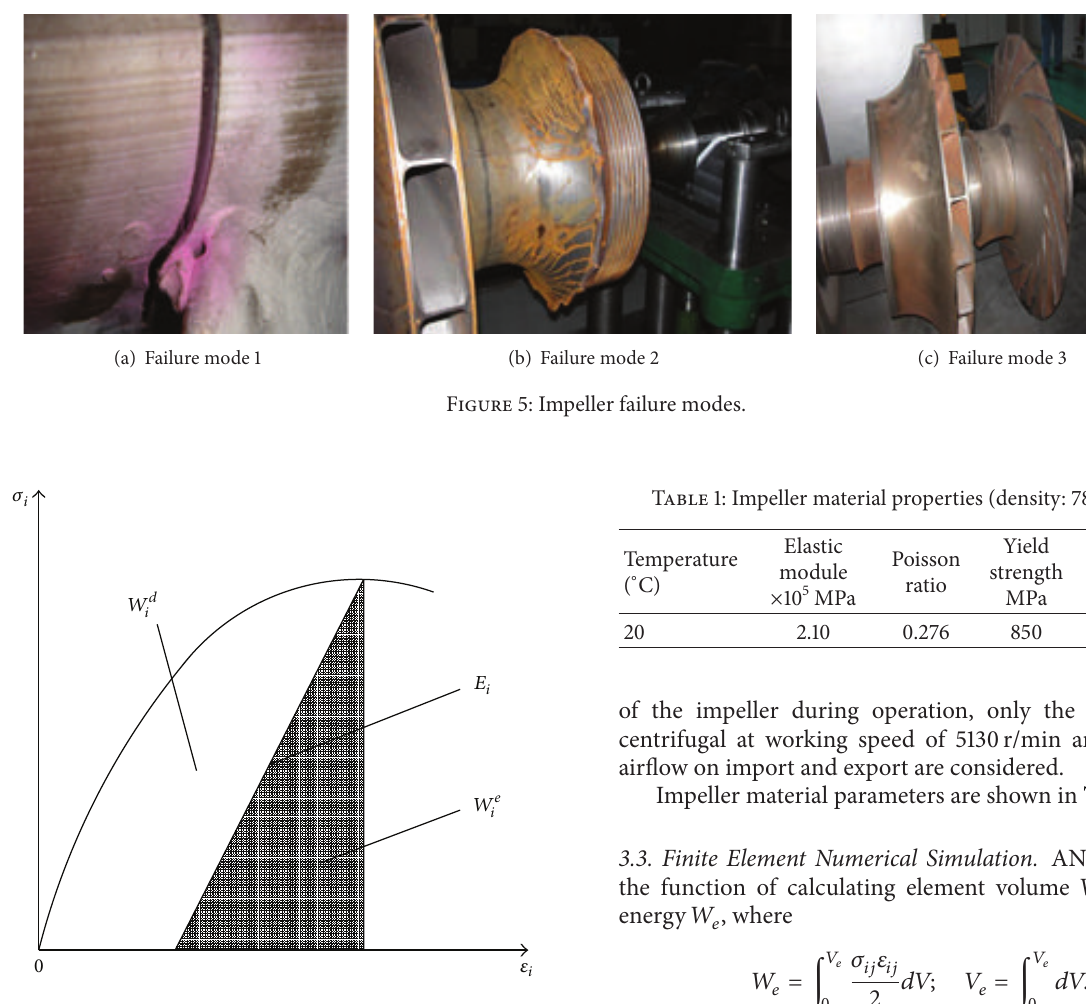
Figure 6: The value of the element energy dissipation and releasable strain energy per unit volume.